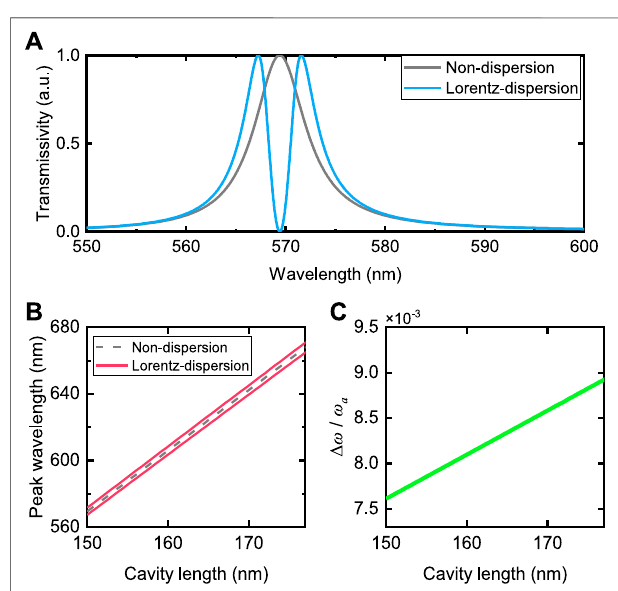
FIGURE2|(A) Transmissionspectrumnearbythe fi rstorderresonance. Whenthemediumisnon-dispersivedielectric,thereisonepeakat569.34 nm (2.1777 eV). When the medium is Lorentz-dispersive dielectric, there are two peaks at 567.20 nm (2.1859 eV) and 571.56 nm (2.1692 eV), respectively. That is, a spectral splitting has been created with an interval of 16.7 meV. (B) Position of transmission peaks versus the cavity length. As the cavity length increases, all peaks red shift and the splitting is so tightly close to the center wavelength that it is hard to distinguish the three lines. (C) The relative splitting degree Δ ω / ω a versus the cavity length. The splitting will increase if the cavity length